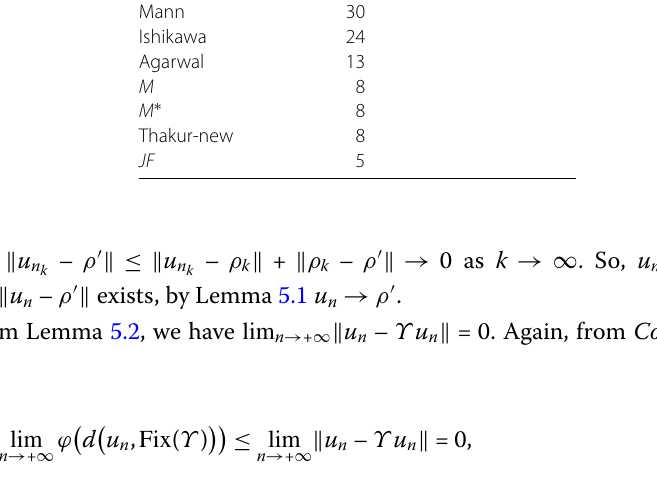
Table 1 Convergence behavior of various iterative process Name of the iterations Number of iterations